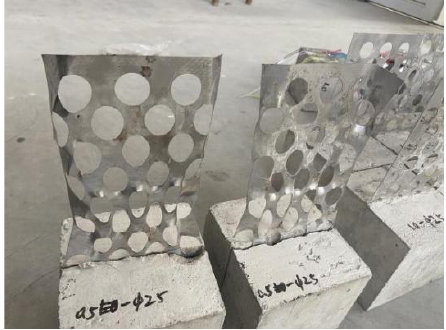
Figure 9. The first kind of destruction.